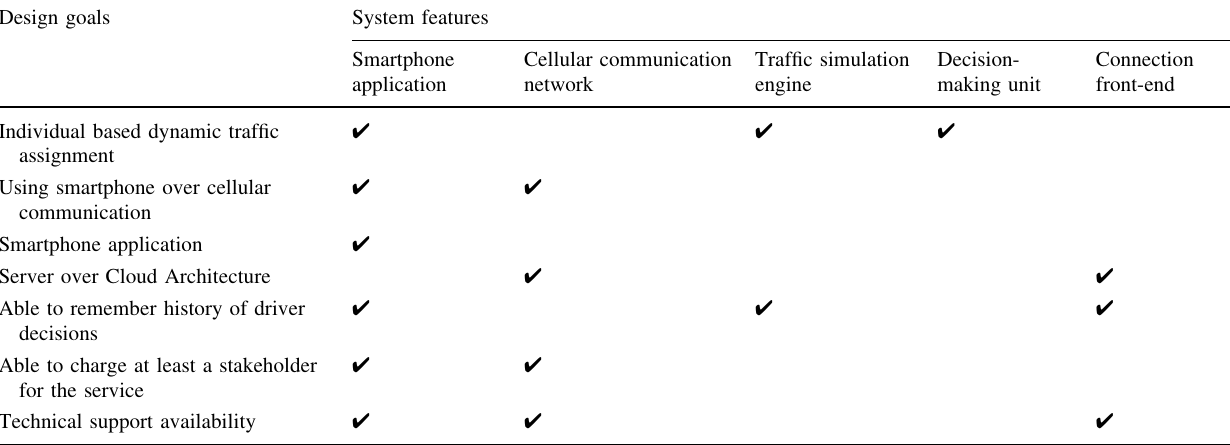
Table 2 Design goal versus system features matrix Design